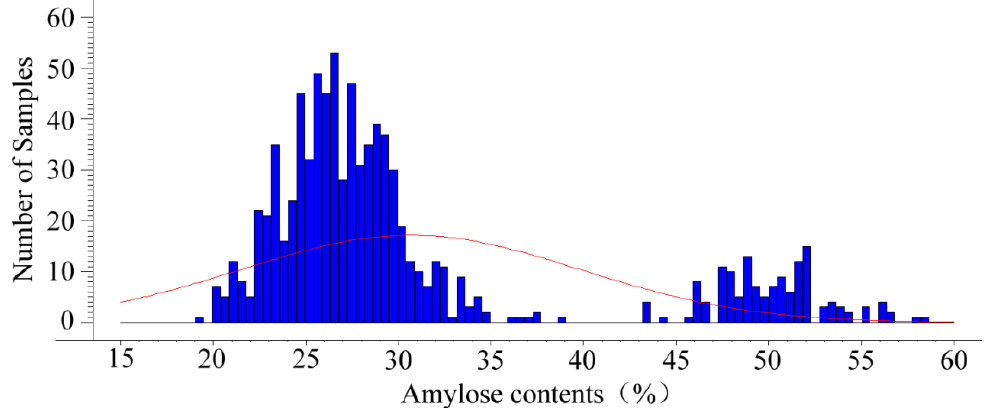
Figure 1. Distribution of amylose contents in single maize kernels (N = 865) determined through chemical analysis method.